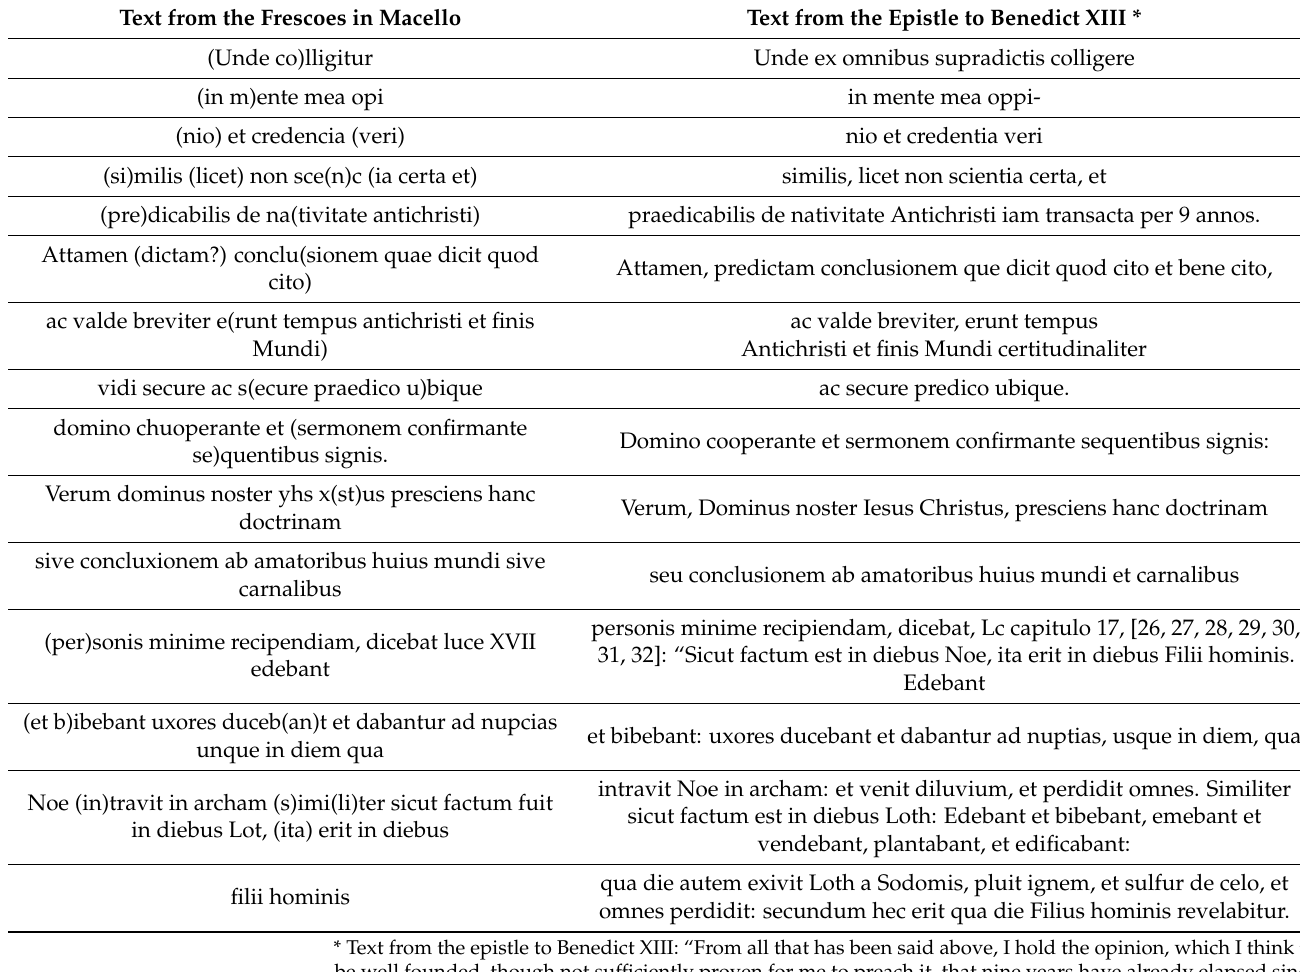
Table 5. Textual comparison, scroll in the scene depicting beatus Vincentius